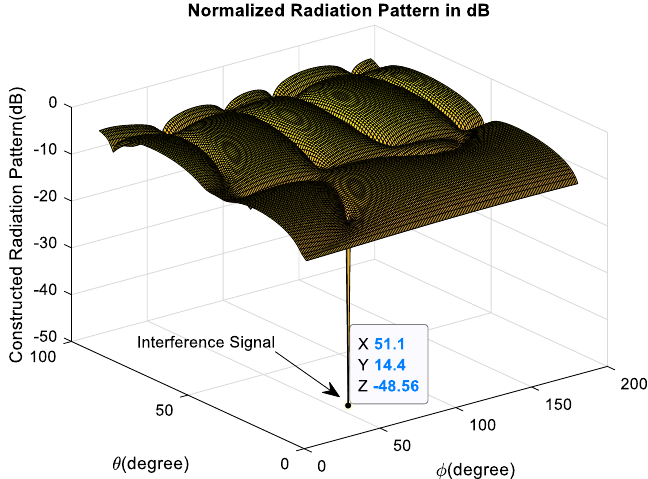
Fig. 10 Normalized radiation pattern of beamforming in presence of three far-field scatterers in dB scale to demonstrate the null depth at the direction of the